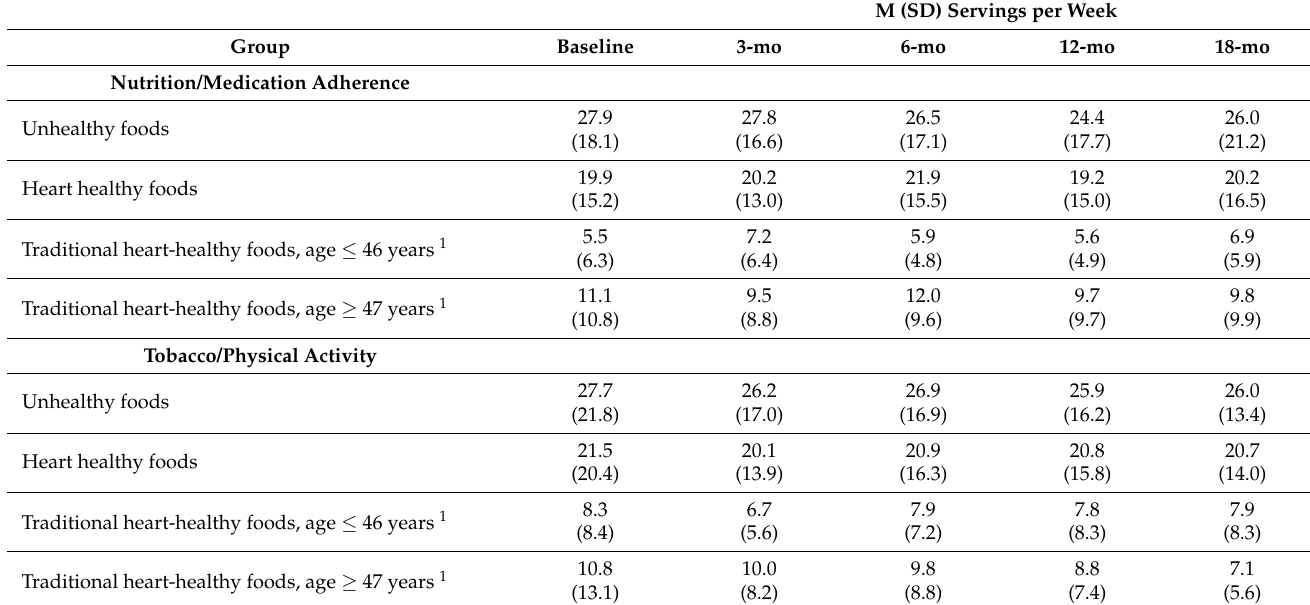
Table 3. Unhealthy foods, heart-healthy foods, and traditional heart-healthy foods servings by condition over time.